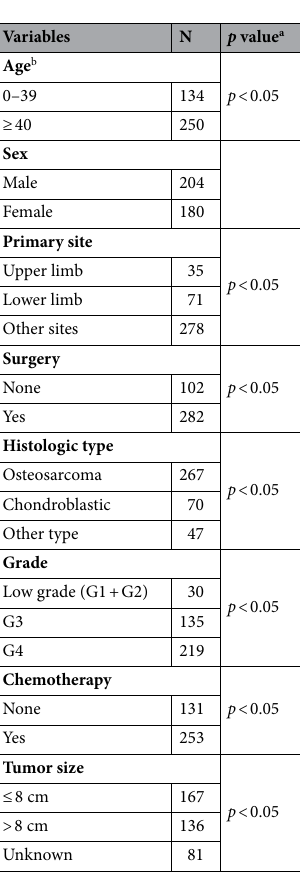
Table 1. Characteristics of patients undergone radiotherapy. a p < 0.05 mains significantly different. b According to the clinical cut-off age of aggressive chemotherapy at 40, we divide age groups into 0–39 and ≥